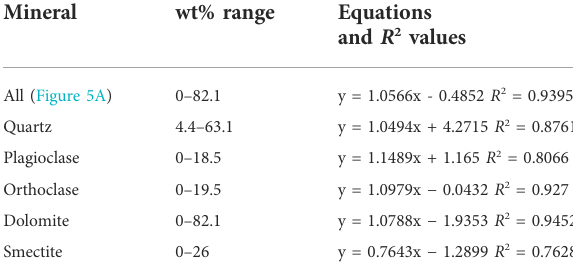
TABLE 3 Equations and R 2 values of trend lines shown in Figure